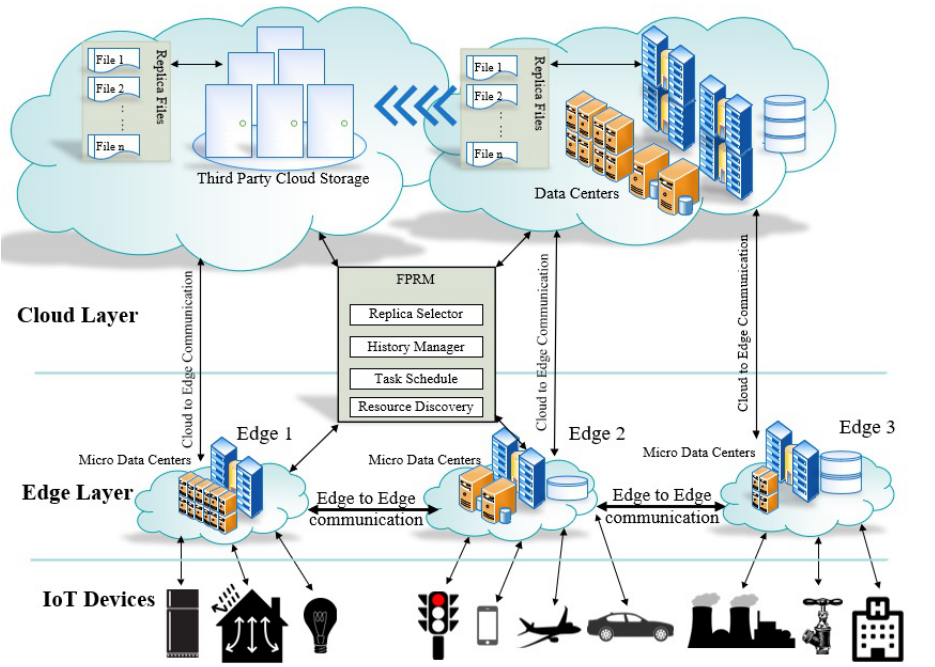
Figure 3. FPRM in Cloud, Edge and IoT